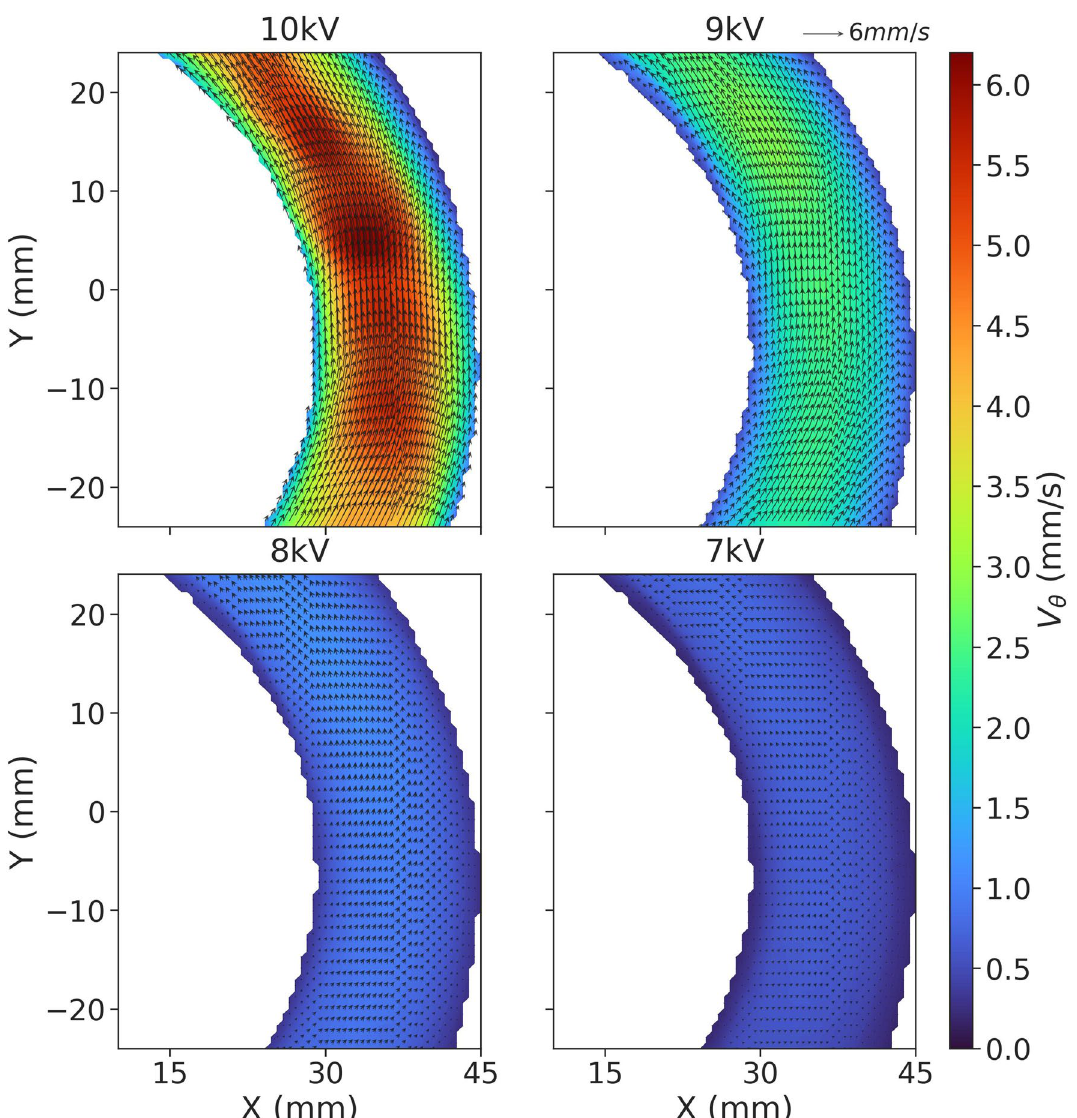
to higher velocities in the oil with enhanced fluctuations at the center of the channel. For a better visibility, only every third vector is in shown in both